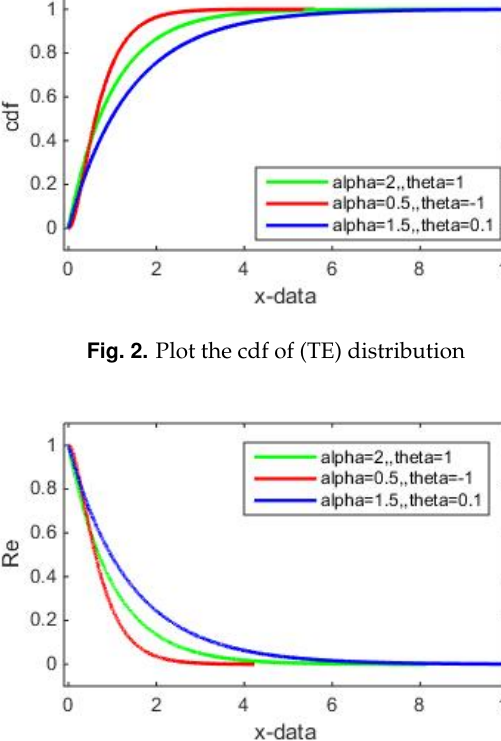
Fig. 3. Plot the Reliability of (TE)